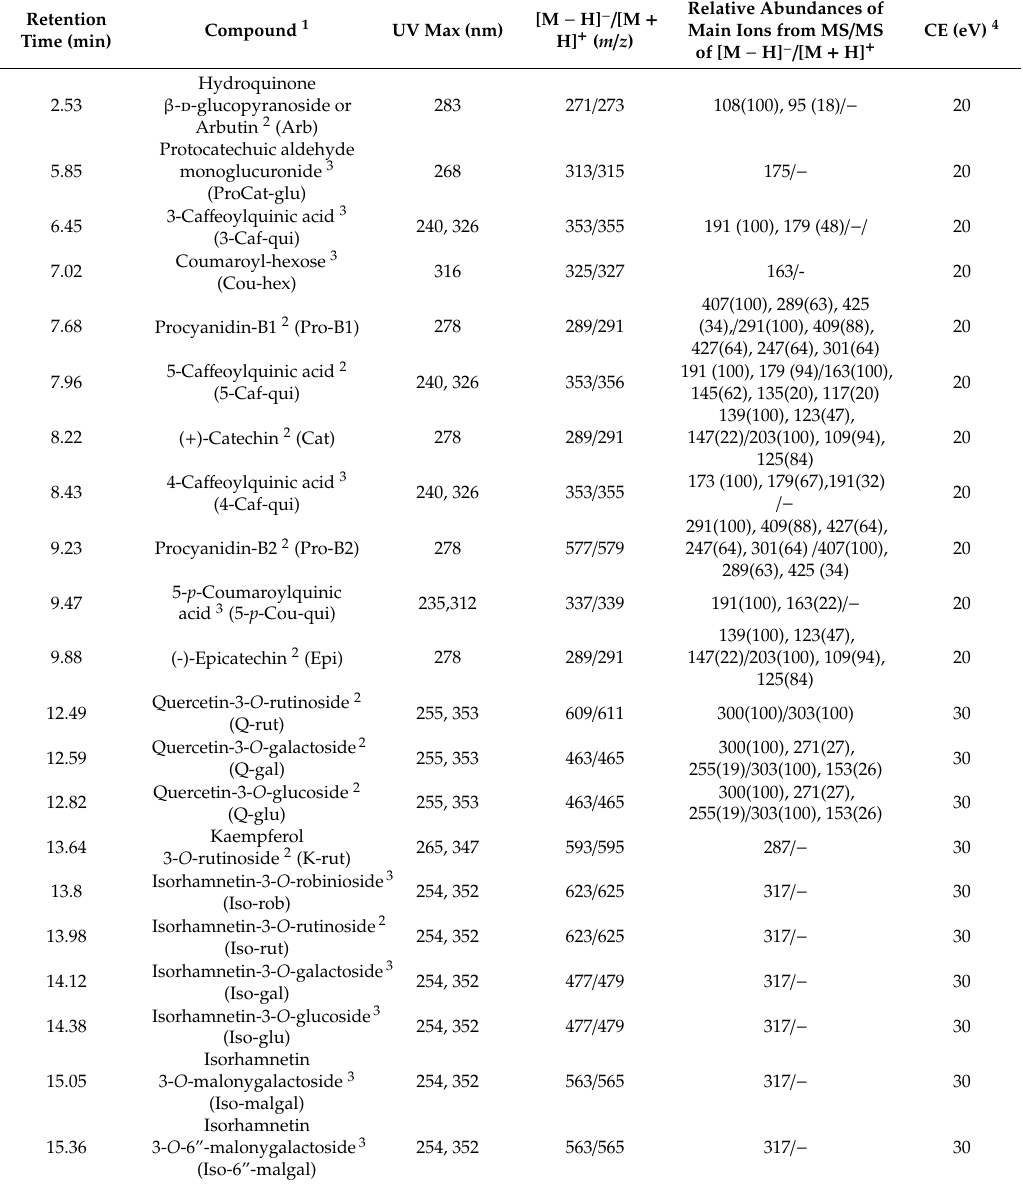
Table 2. The chromatographic, UV-vis, and MS parameters of the phenolic compounds identified in the